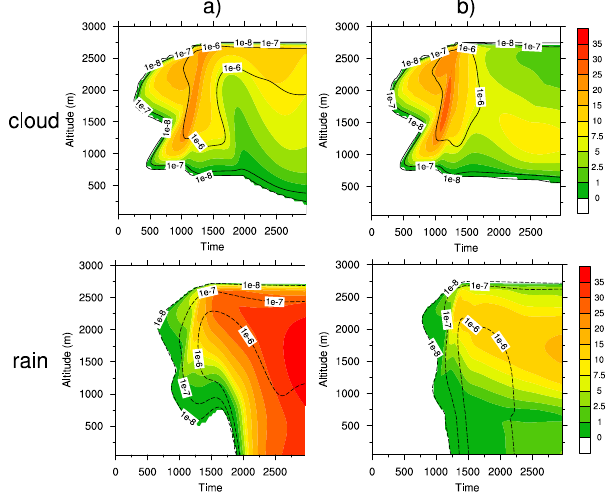
Figure 4. HaRP case: same as Figure 2 but for sulphuric acid in cloud water and in rainwater 3 Fig. 4. HaRP case – same as Fig. 2 but for sulphuric acid in cloud (pptv). 4 water and in rainwater (pptv).